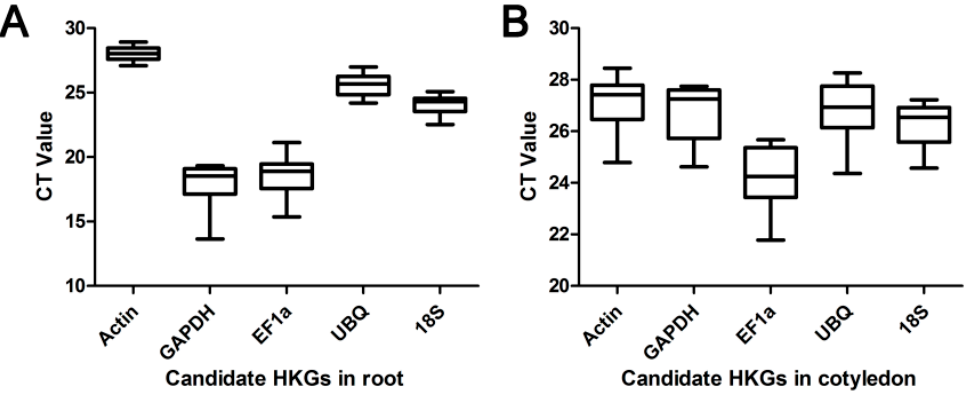
Figure 3. C t variation among experimental sets of Chinese fir root ( A ) and cotyledon ( B ), shown as Box-whisker plot. The median is presented as the line across the box. The upper and lower edges bordered in each box are interquartile range, which indicate the 25th and 75th percentiles.